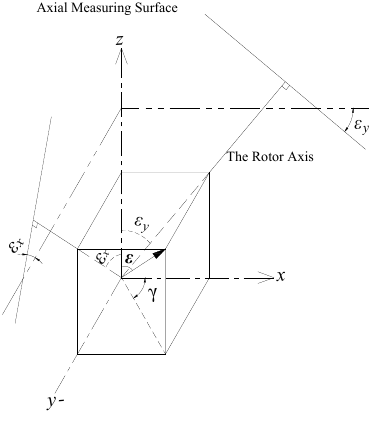
Figure 14. Schematic diagram of tilt error motion decomposition.